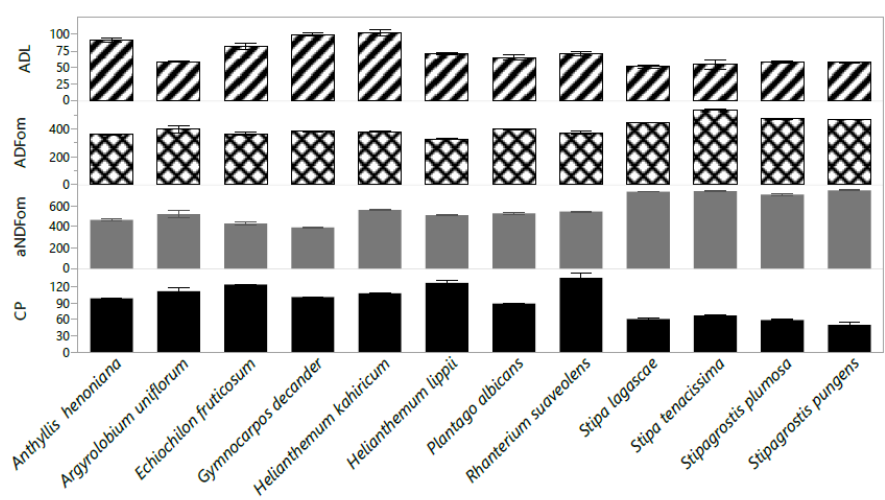
Figure 4. The chemical composition crude protein (CP; g/kg DM), acid detergent fiber (ADFom; g/kg DM), neutral detergent fiber (aNDFom; g/kg DM) and acid detergent lignin (ADL; g/kg DM) of twelve native perennial species from arid rangelands of southern Tunisia. Values are the means ± standard error (SE) from 3 replicates (means ± SE). The metabolizable energy concentration varied between 5.5 and 7.7 MJ kg DM − 1 with the highest value for A. uniflorum and E. fruticosum and the lowest for H. kahiricum (Figure 5). The IVOMD of E. fruticosum and A. uniflorum was the highest (579 and 573 g kg − 1 , respectively) and lowest in H. kahiricum (425 g kg DM) with significant differences between species. The means of IVOMD and metabolizable energy (ME) followed a similar trend. Relative feed values (RFV) varied ( p < 0.05 ) among species was lowest in S. tenacissima (53) and highest in G. decander (132). Among all species studied, Stipa recorded the lowest values for RFV, ranging from 53–62 (Figure 5).